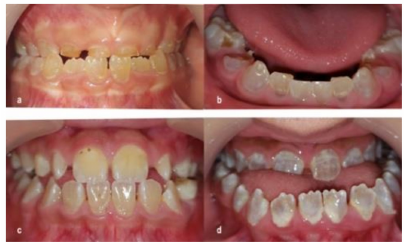
Figure 1. Tooth discoloration in DI patients: ( a ) yellow-brown discoloration in primary teeth; ( b ) opalescent-gray discoloration in primary teeth; ( c ) yellow-brown discoloration in permanent teeth; ( d ) opalescent-gray discoloration in permanent teeth.